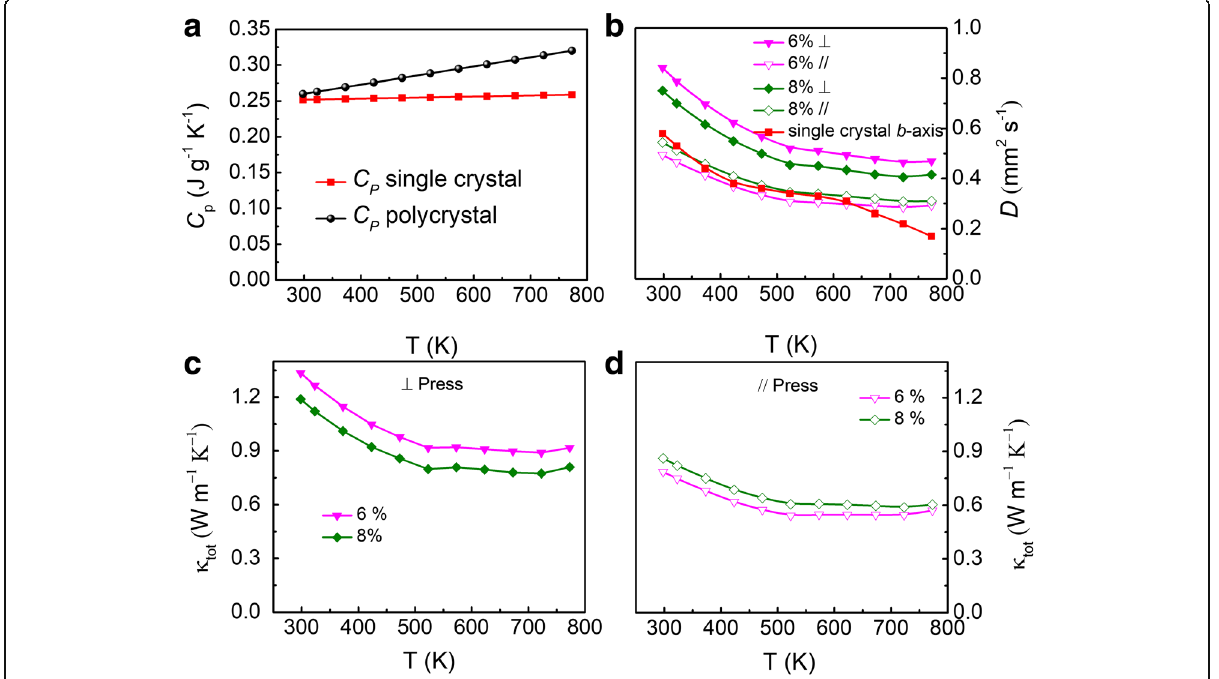
Fig. 4 (Color online) Temperature dependence of heat capacity ( C p ) taken from [1] ( a ), thermal diffusivity ( D ) ( b ), and thermal conductivity ( κ ) of SnSe:Bi 6% and SnSe:Bi 8% samples along both ⊥ and // directions compared with Bi-doped n-type SnSe single crystal [7] ( c , d